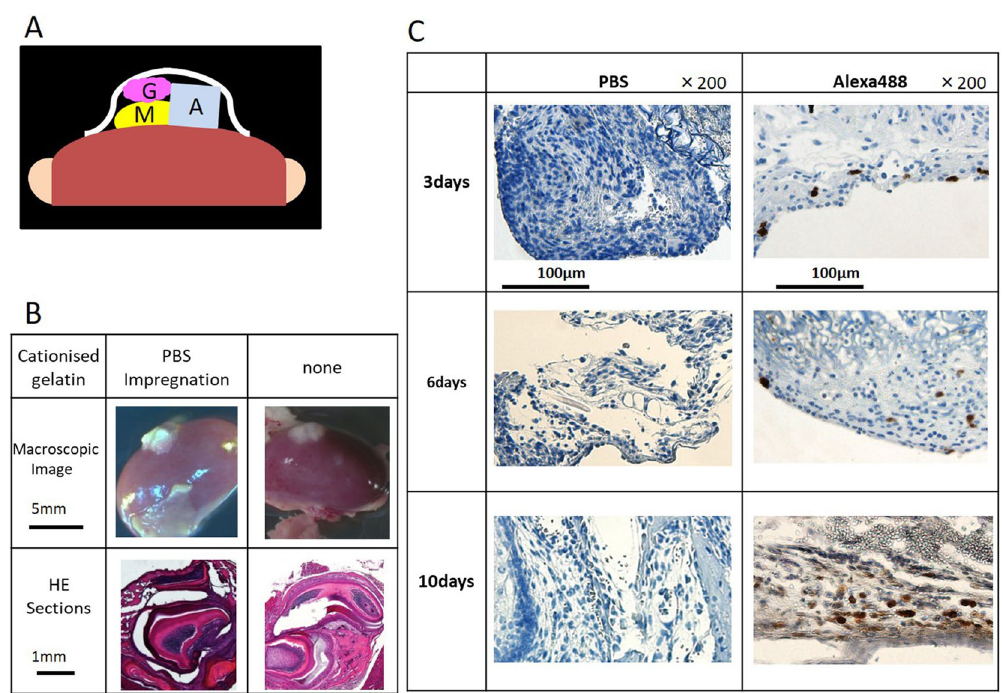
Figure 2. Renal capsule assays using lateral mandibles from wild-type mice. ( A ) Schematic illustration of the procedure used for renal capsule transplantation. M indicates the lateral mandibles of E10 mice, G indicates cationized gelatin containing Stealth siRNA, and A indicates agarose agar (was used to maintain the graft space). ( B ) We evaluated H&E-stained sections, where the lateral mandible from wild-type mice was transplanted beneath the kidney capsule of nude mice (KSN/Slc). Renal capsule assays were performed with two groups: lateral mandibles transplanted with or without a cationized gelatin sheet containing PBS. Based on histochemical staining, we observed that the sections contained tooth structures, although we found no differences in the results with or without cationized gelatin. ( C ) Histological sections at days 3, 6, and 10 post -transplantation. Sections were evaluated by immunostaining. Magnification, 200× . Cells were immunostained with an Alexa Fluor 488-conjugated